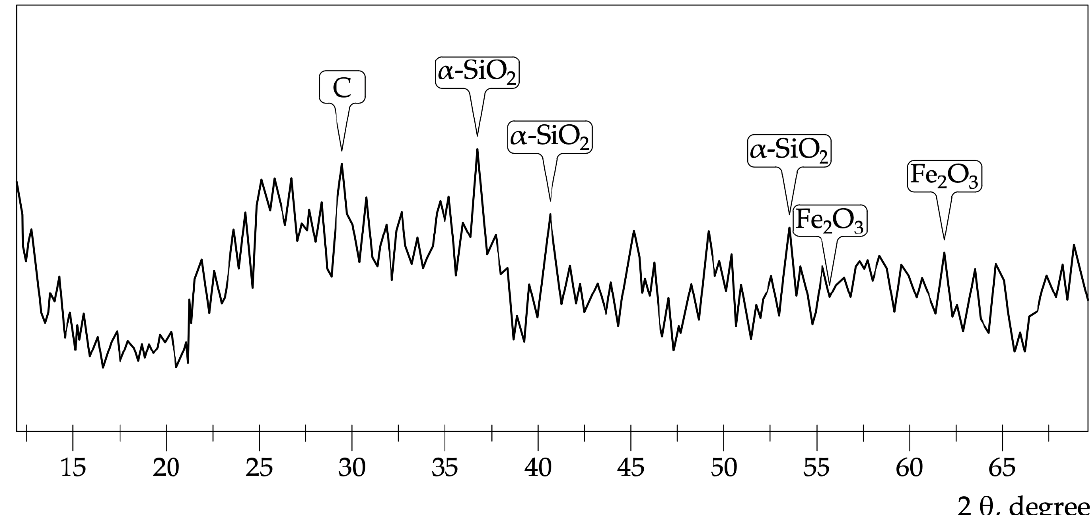
Figure 3. Micro silica diffraction pattern.